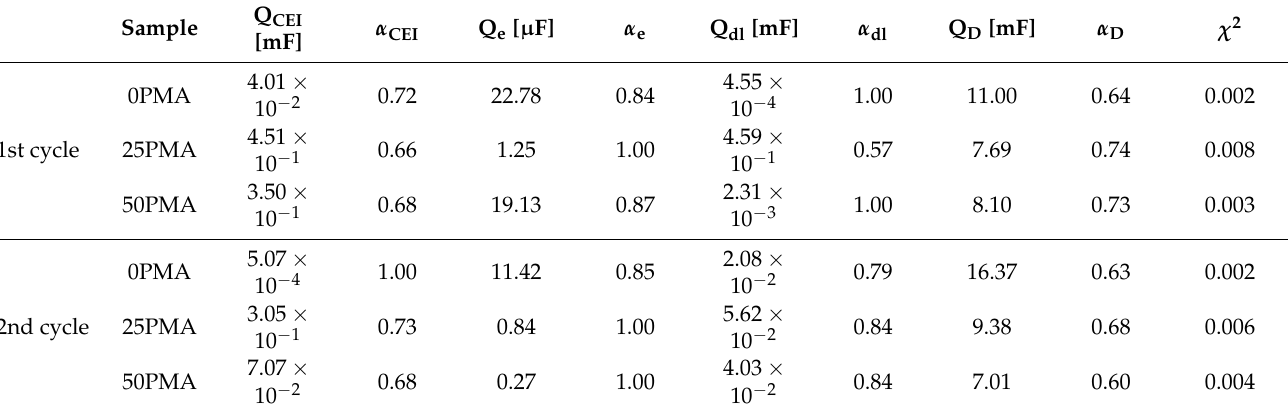
Figure A7. Galvanostatic (CC) and potentiostatic (CV) contributions to the specific charge capacities for 0.2C, 0.5C, and 1C. Table A1. Parameters of constant phase elements determined from fitting the equivalent circuit model to the spectra and error value of the